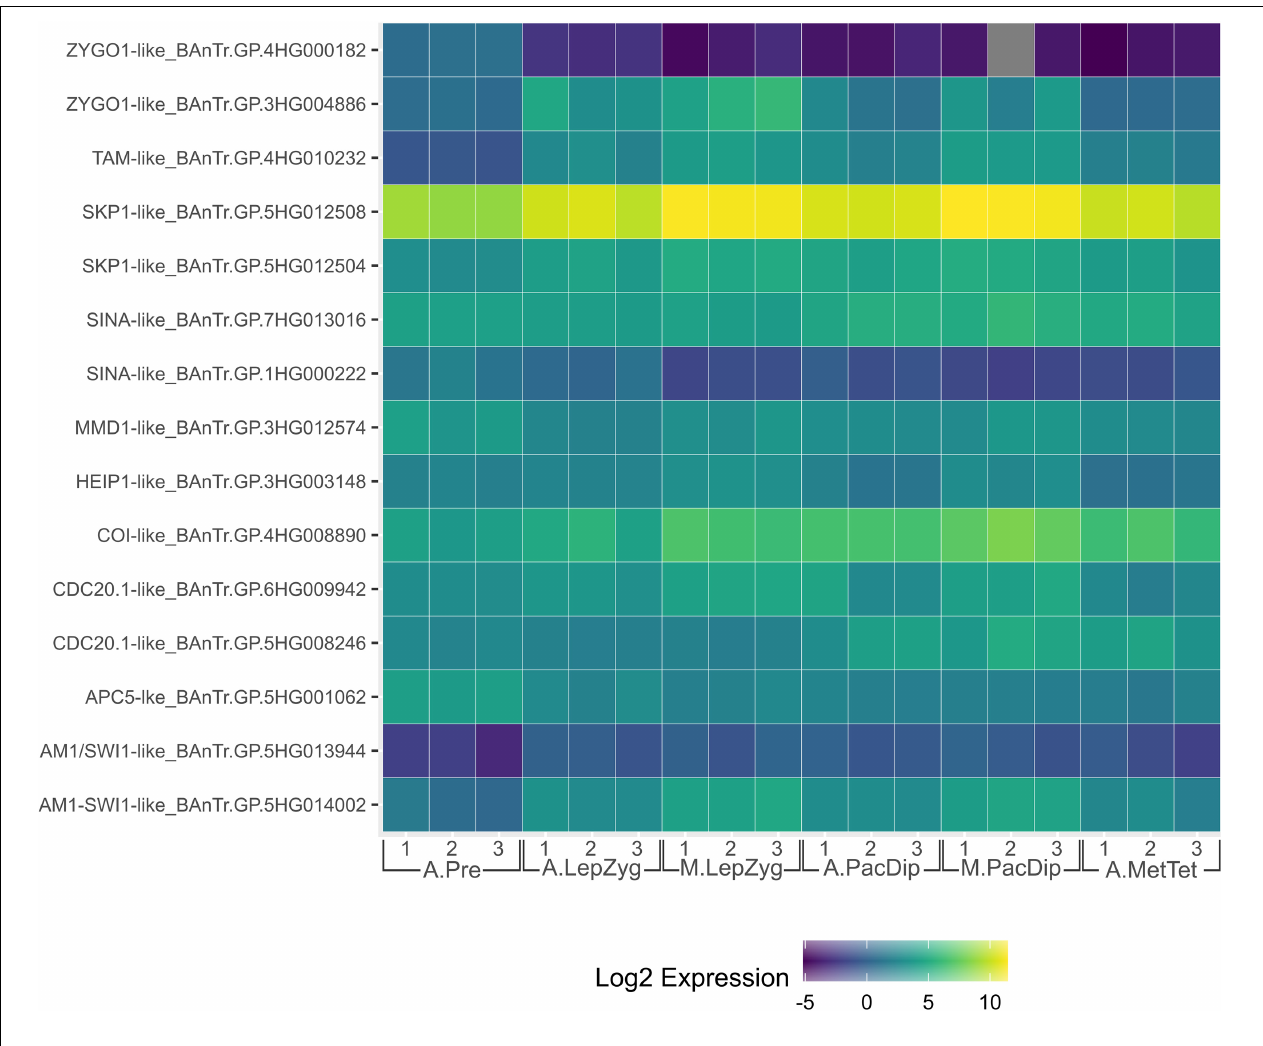
FIGURE 2 | Heat map of expression of genes orthologous to those discussed in this review in the Barley Anther and Meiocyte Transcriptome (BAnTr) dataset. Three replicates each of anthers at pre-meiosis (A.Pre); anthers at leptotene–zygotene stages (A.LepZyg); meiocytes at leptotene–zygotene stages (M.LepZyg); anthers at pachytene–diplotene stages (A.PacDip); meiocytes at pachytene–diplotene stages (M.PacDip); and anthers at metaphase–tetrad stages